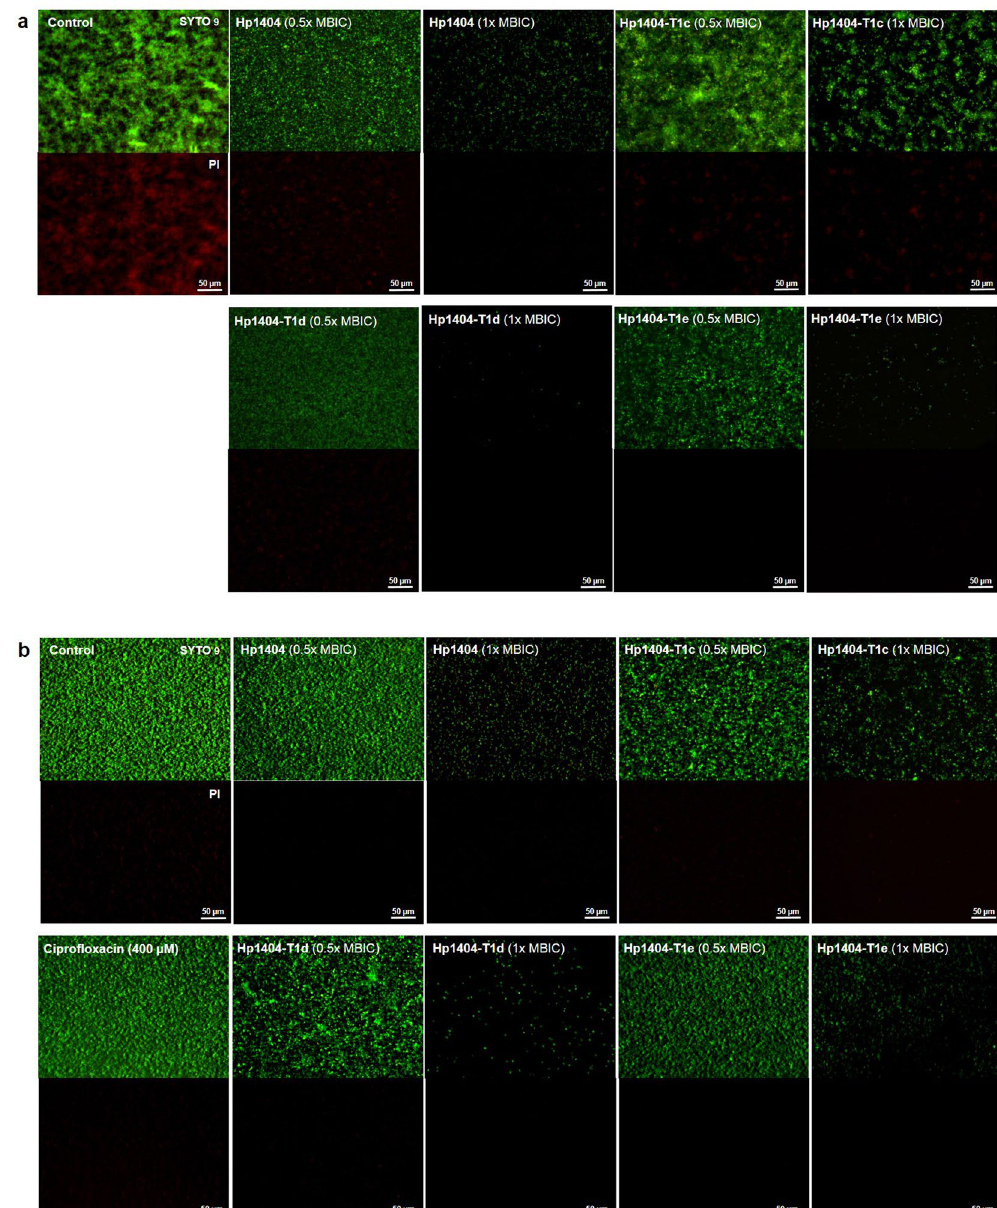
Figure 3. Fluorescence microscopy images of live/dead stained P. aeruginosa biofilms after treatment with peptides at 0.5 × or 1 × MBIC. Living cells are stained in green (SYTO9 dye), while dead cells are stained in red (propidium iodide). ( a ) P. aeruginosa ATCC 27853 ( b ) P. aeruginosa 1034. Scale bar = 50 µ